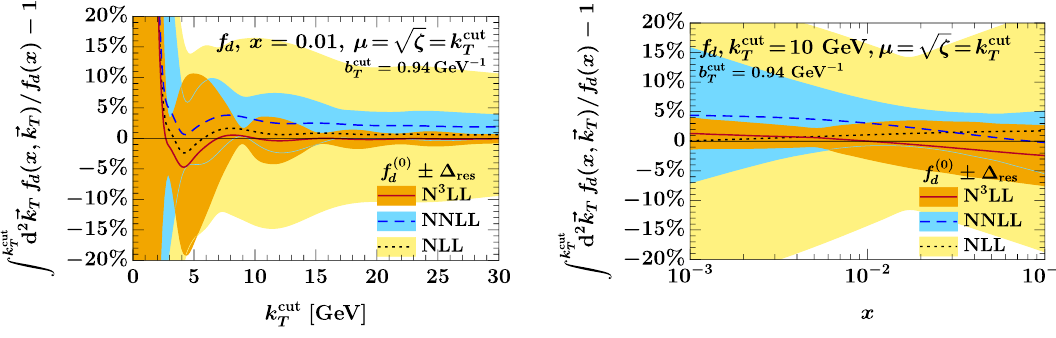
Figure 7 . Similar to figure 6, but for the perturbative uncertainties from resummation orders, which are estimated from varying the scales in the boundary condition of the TMD PDF evolution. When increasing the resummation order, the uncertainty bands converge. The central values at all orders are within a few percent from the collinear PDF. See figure 13 in appendix B for the results for other light quark flavors including u, ¯ d, ¯ u , and s